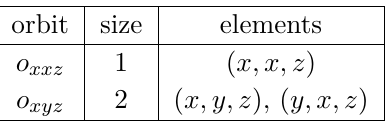
Table 9. Orbit types for the frame with d ref = ( n 1 , n 1 , n 2 ) , where n 1 and n 2 are distinct, nonzero integers. Here x 6 = y , while z is